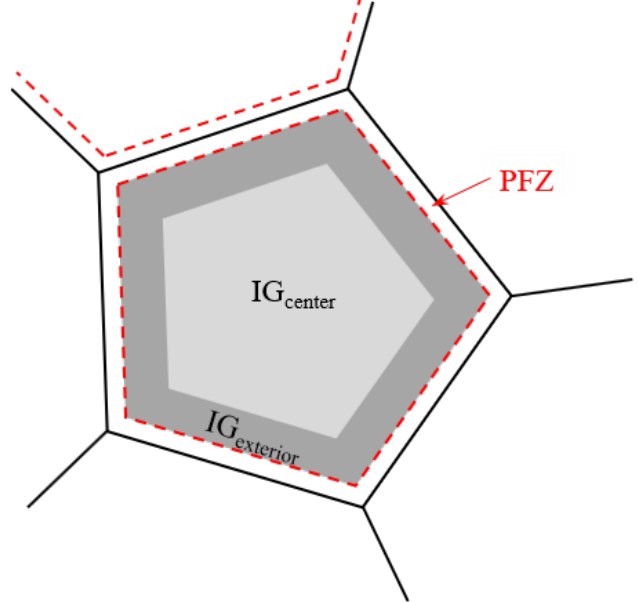
Figure 6. Schematic representation of the typical microstructure of recrystallized and quality heat- treated ferritic Laves-phase-strengthened steel [30].